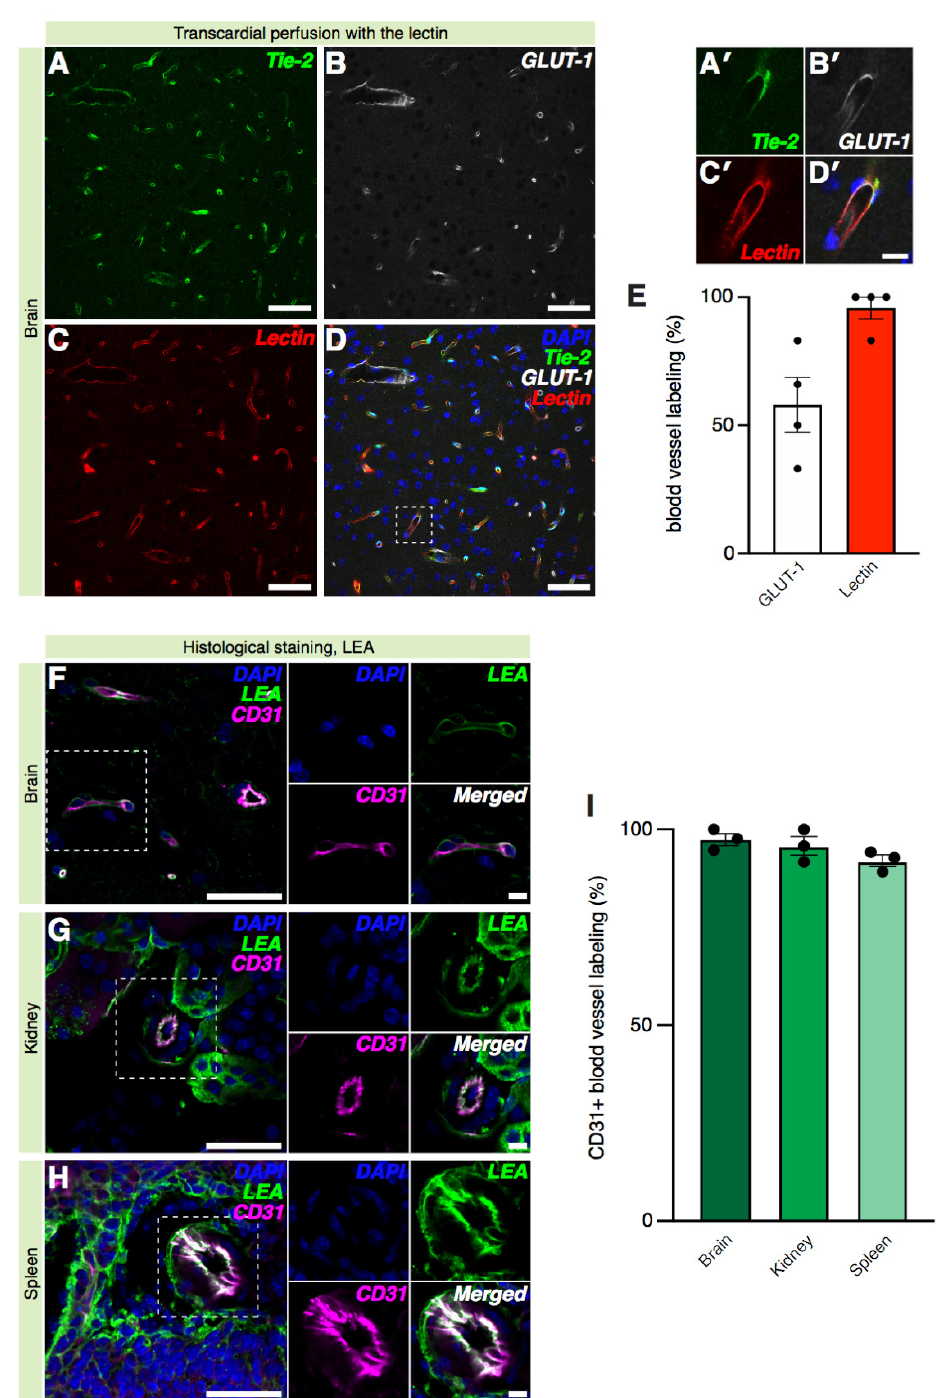
Figure 4. Comparison of lectin labeling of blood vessels in different types of the endothelium with the commonly used blood vessel markers. ( A – D ) Representative 20 × confocal images of a brain section from a Tie2–eGFP reporter mouse intracardially perfused with the biotinylated lectin and processed with Cy3-conjugated streptavidin and GLUT-1 antibodies. Scale bars: 50 µ m. The white dashed square marks the magnified inset in ( A ′ – D ′ ). Scale bars: 10 µm. ( E ) Quantification of blood vessels labeled (%) by GLUT-1 and lectin staining; n = 4 mice (Wilcoxon test, p = 0.2500). ( F – H ) Representative 20 × confocal images of the brain, kidney, and spleen sections labeled with the CD31 endothelial marker. Scale bars: 50 µ m. White dashed squares mark the magnified insets on the right. Scale bars: 10 µ m. ( I ) Quantification of CD31 + blood vessels (%) in the brain, kidney, and spleen tissues that are co-labeled with LEA; n = 3 mice (one-Way ANOVA, p = 0.1894).